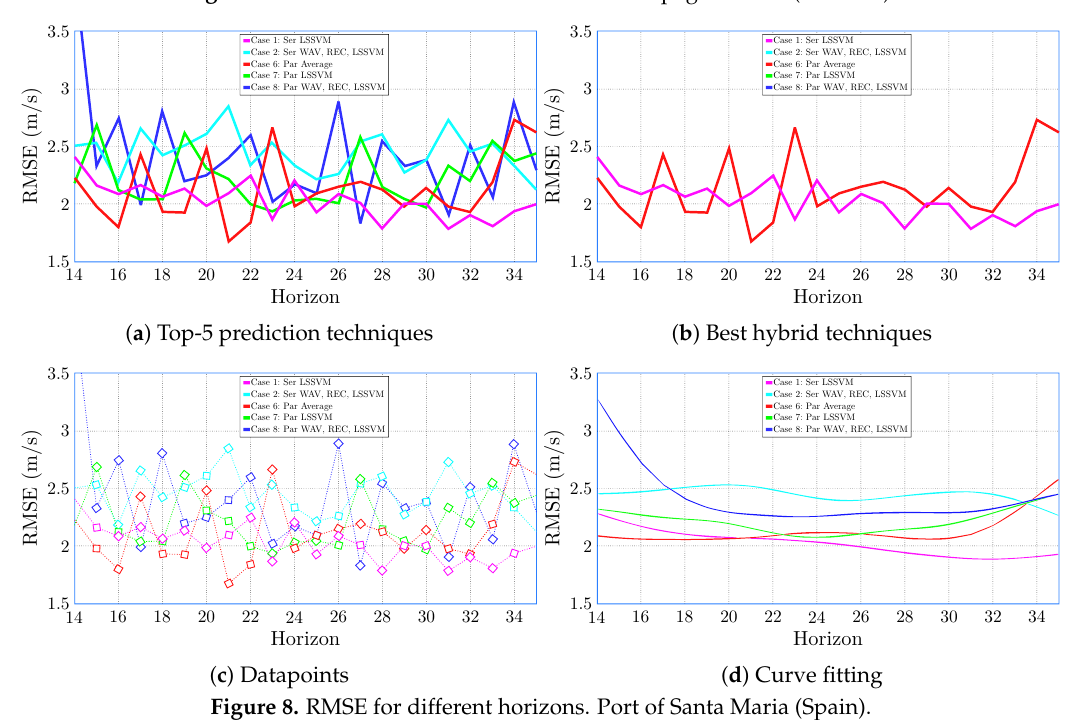
Figure 8. RMSE for different horizons. Port of Santa Maria